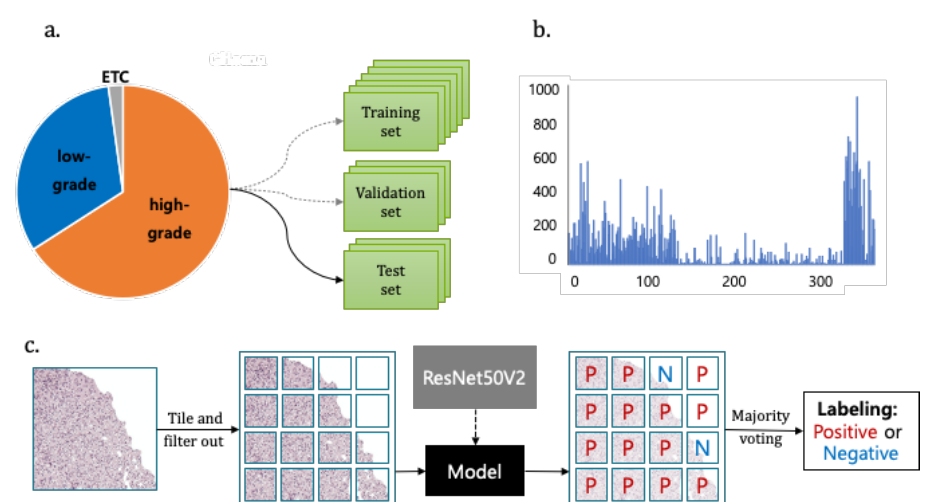
Figure 3. The dataset and strategy for the classification of glioma subtype using deep transfer learning and majority voting technique ( a ). The ratio of low-grade vs. high grade gliomas. ( b ) The distribution of patch numbers from one Whole Slide Image. ( c ) Transfer learning with ResNet50V2 model and majority voting technique for labeling glioma patient images.